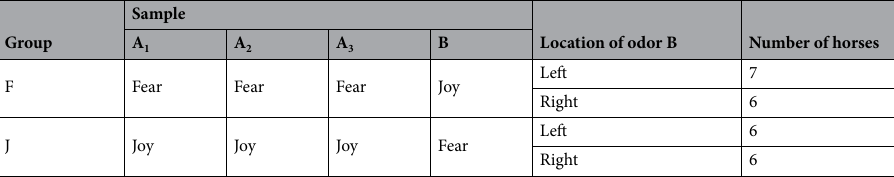
Table 1. Randomization of stimuli presentation. Of the 30 horses that participated in the test, 5 did not sniff the sample and were excluded from further analysis; this table gives information for the 25 remaining horses (see “Statistical analysis”).